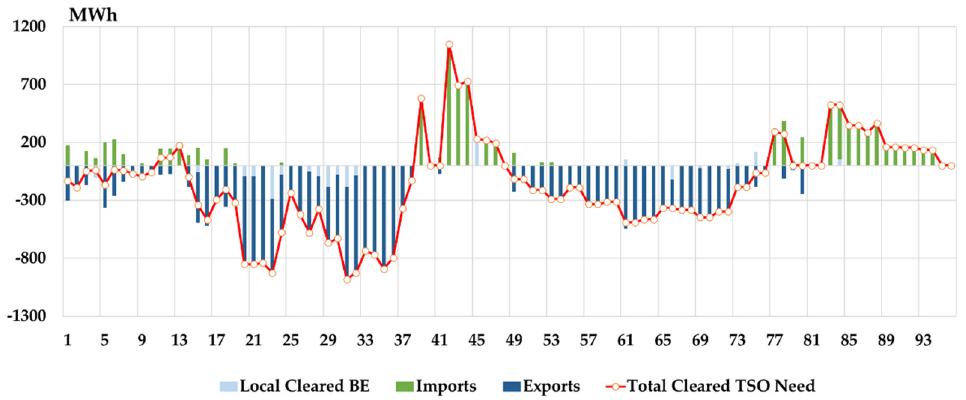
Figure 19. Power balance and cleared mFRR BE quantities per RTU for France.